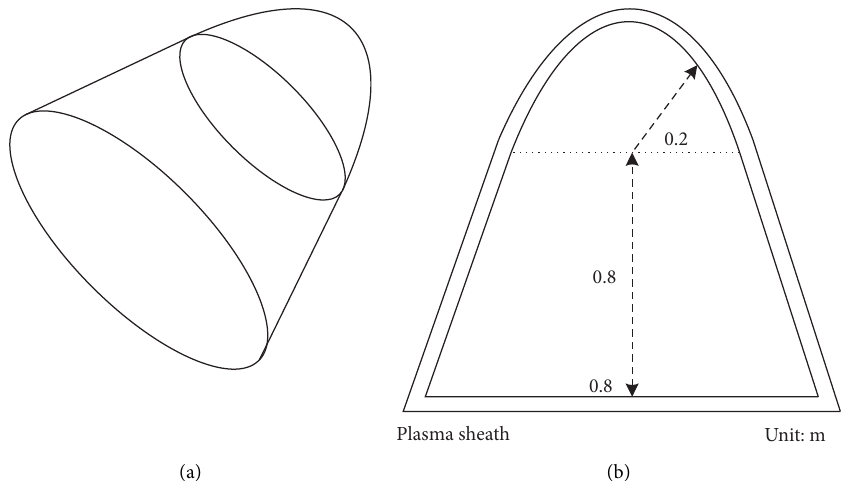
Figure 1: The sketch picture and detail parameters of flight vehicle model: (a) whole model; (b) front view.